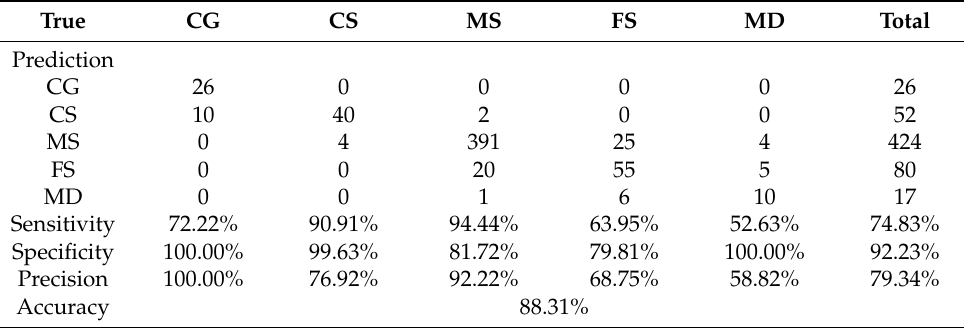
Table 4. The confusion matrix of the predicted